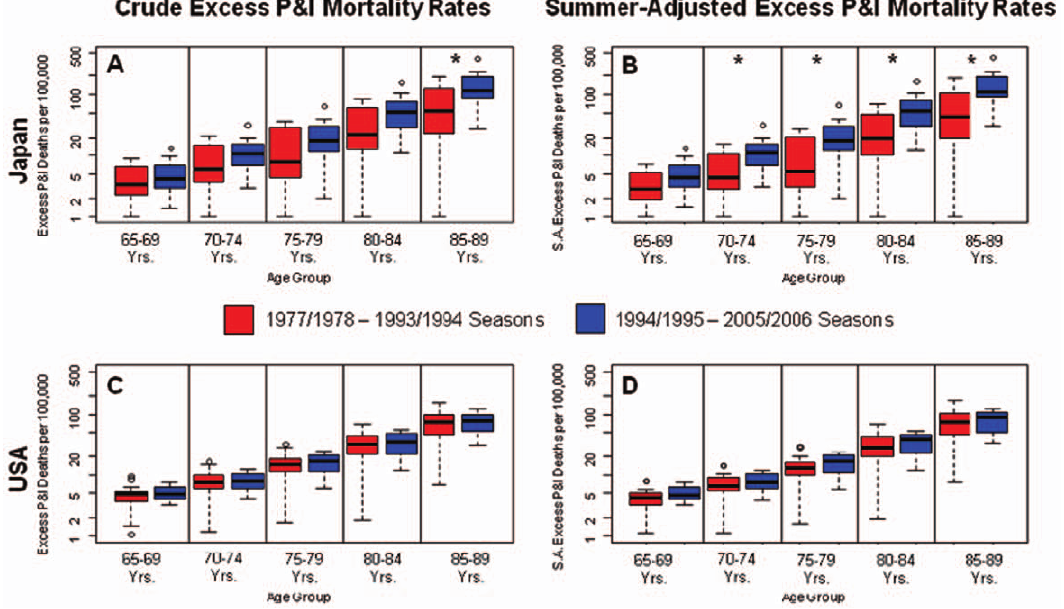
Figure 3. Crude (left panels) and adjusted (right panels) excess pneumonia & influenza (P&I) seasonal mortality rates by age group and time period in Japan (top) and the US (bottom). Rates were adjusted for time trends in the baseline risk of mortality. Asterisks indicate statistically significant differences between the two time periods using Wilcoxon’s Rank Sum Test (P , 0.05).